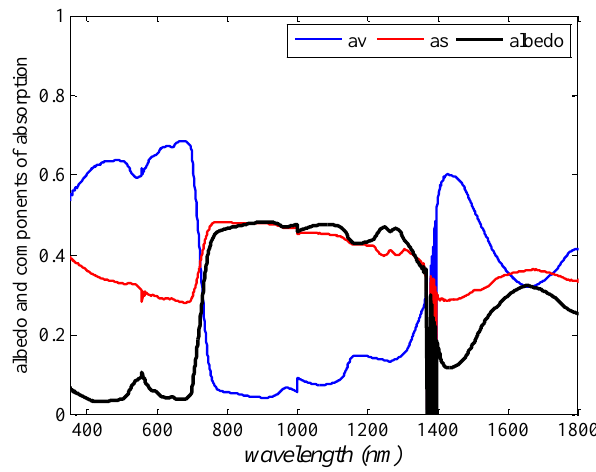
Figure 7. Spectral albedo and components of absorption.